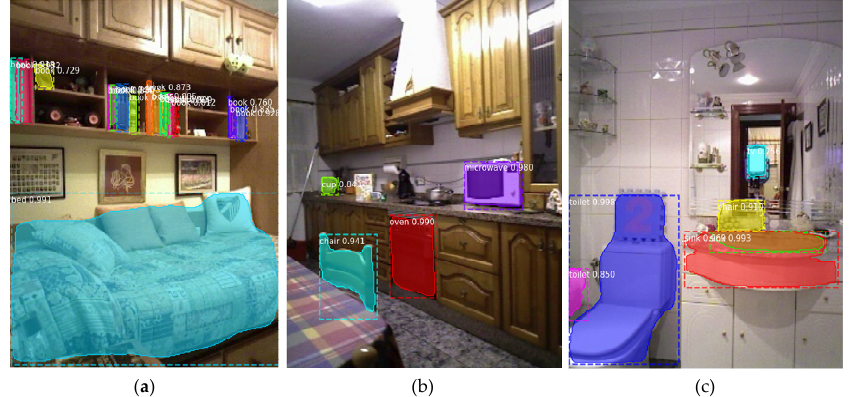
Figure 4. Detected objects by Mask R-CNN: ( a ) a bed and many books; ( b ) a chair, an oven, a microwave, and a cup; and ( c ) two toilets, two sinks, a chair, and a TV.